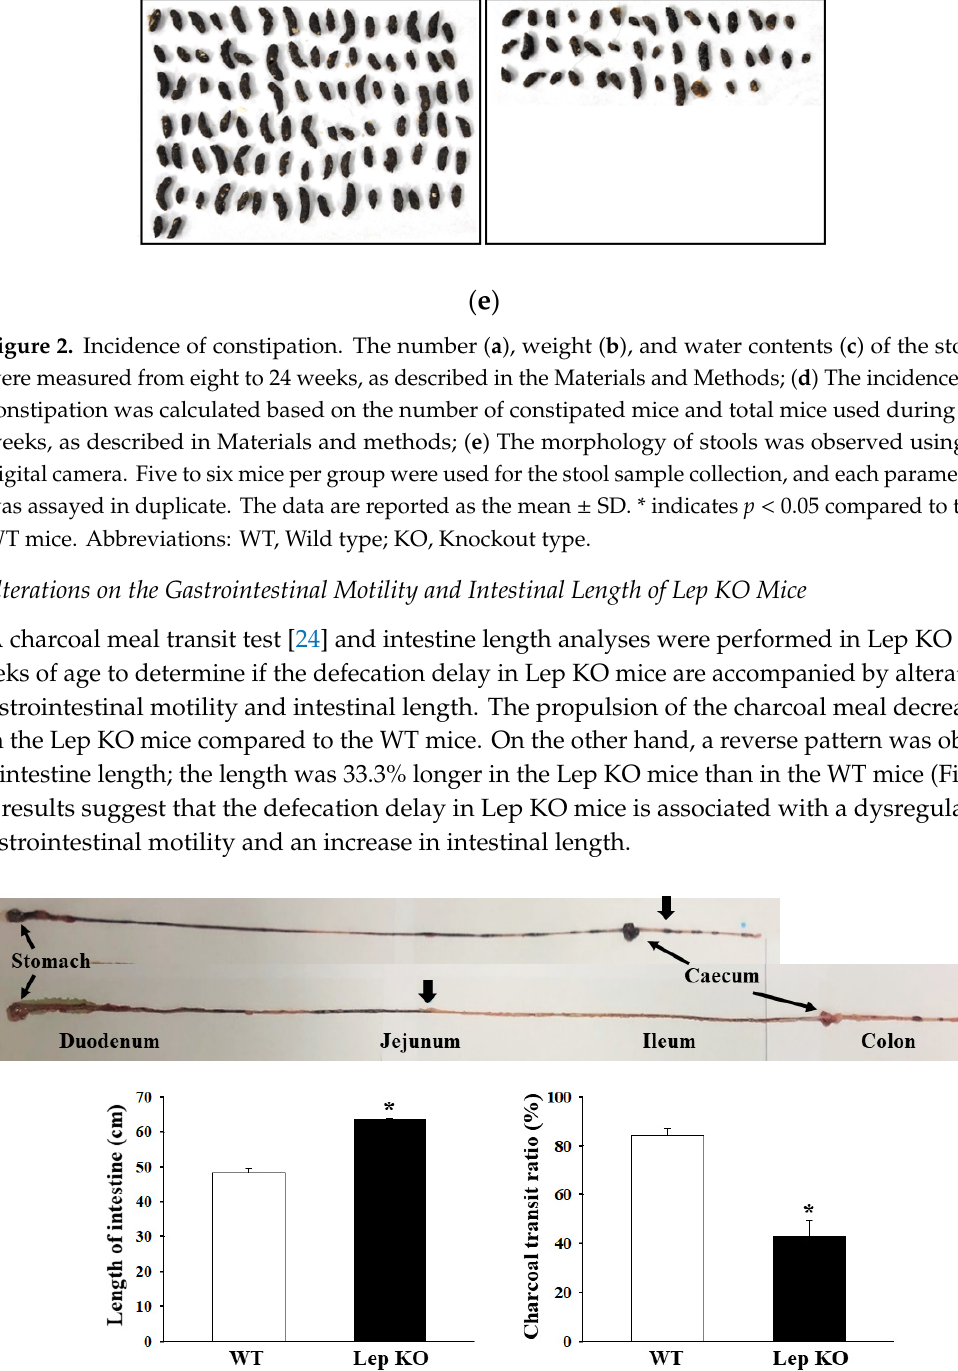
Figure 3. GI transit ratio and intestinal length of Lep KO mice. The total intestinal tract was excised from the rats of the subset groups treated with charcoal meal powder. The morphology was observed using a digital camera. The arrows indicate the position of the charcoal meal. The total distance traveled by the charcoal meal from the pylorus was measured. The charcoal meal transit ratio was then calculated using the total length of the intestine and the distance of the charcoal meal. Three to five mice per group were used in the gastrointestinal transit ratio test, and the charcoal meal transit distance and intestine length were measured in duplicate. The data are reported as the mean ± SD. * indicates p < 0.05 compared to the WT mice. Abbreviations: WT, Wild type; KO, Knockout type.